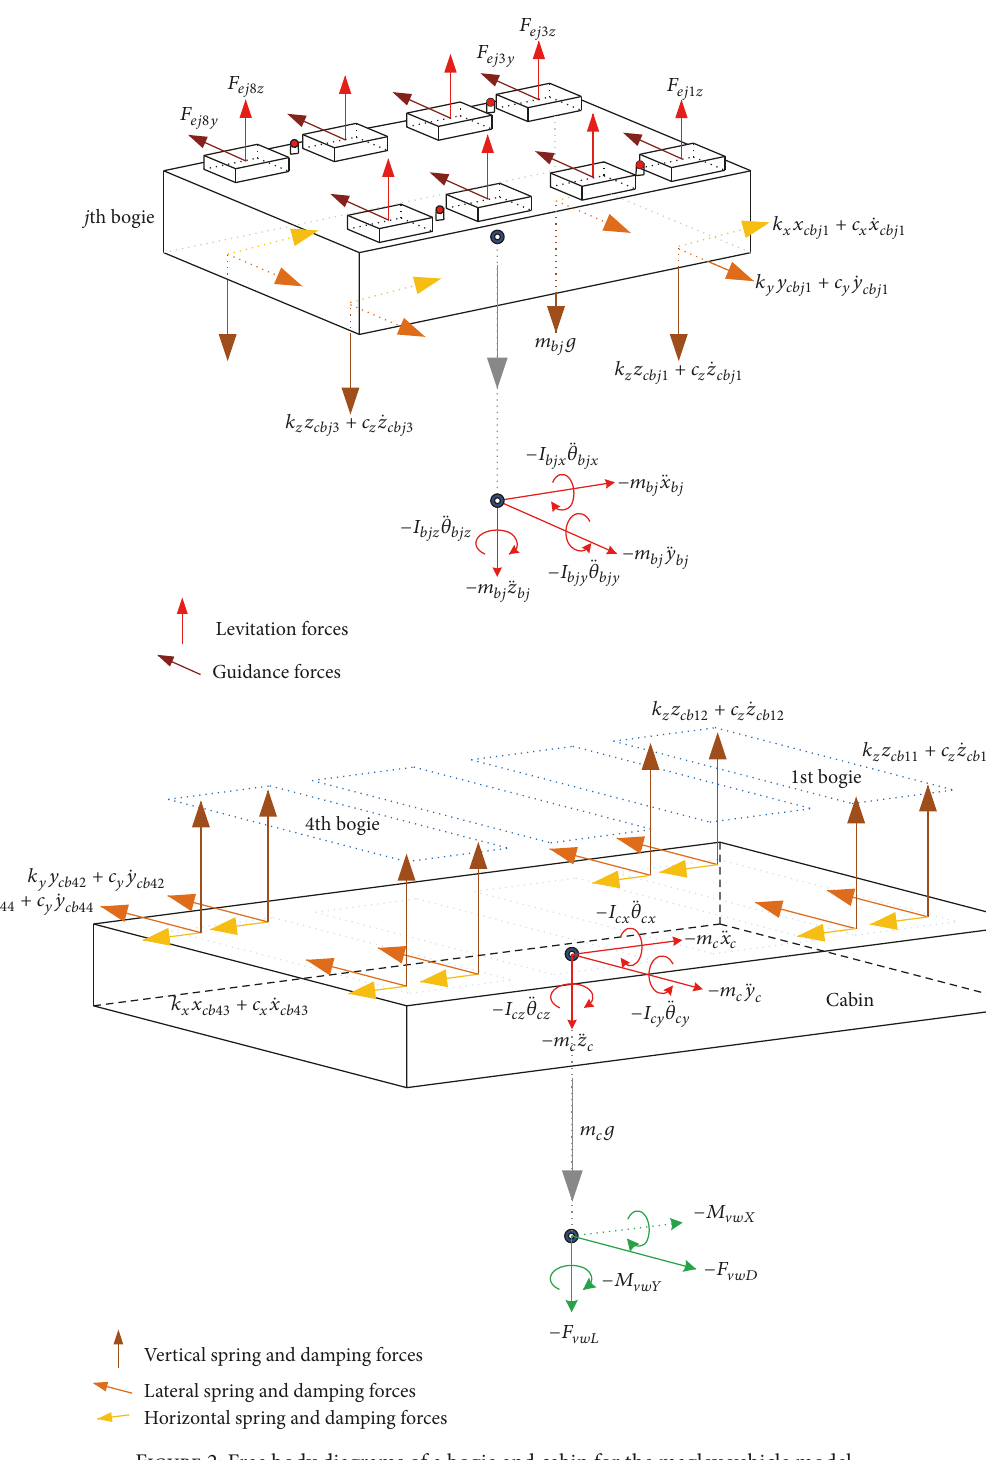
Figure 2: Free body diagrams of a bogie and cabin for the maglev vehicle